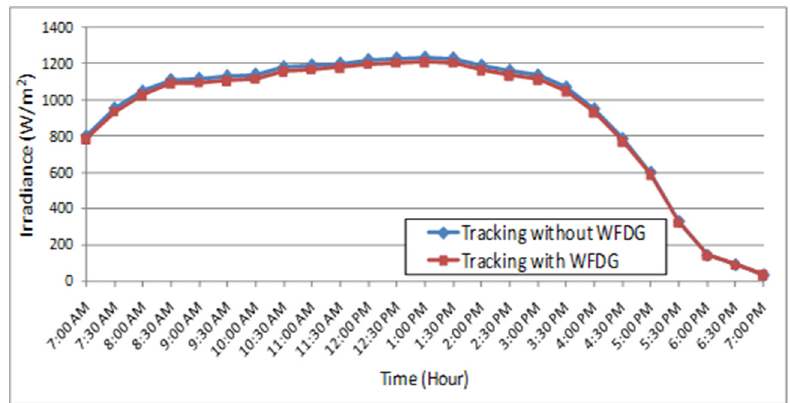
Fig. 7. Solar irradiance through day